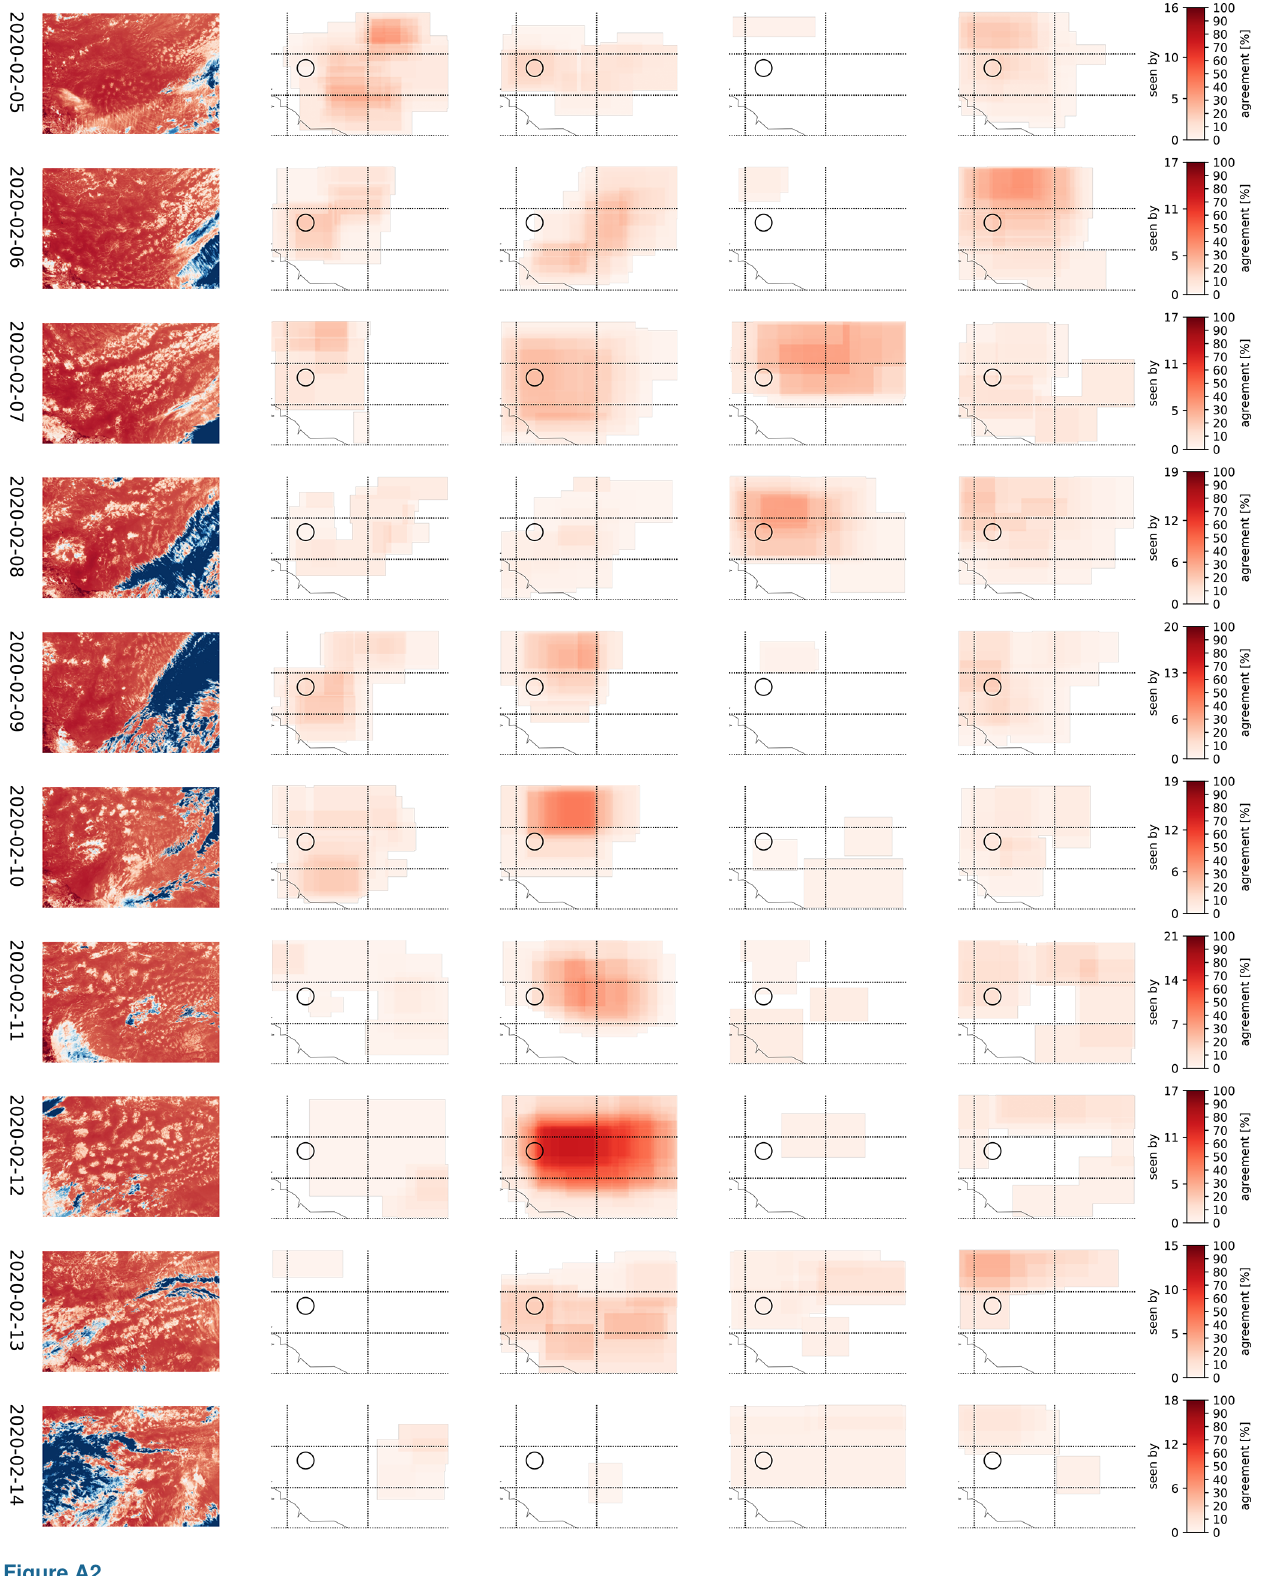
https://doi.org/10.5194/essd-14-1233-2022 Earth Syst. Sci. Data, 14, 1233–1256,